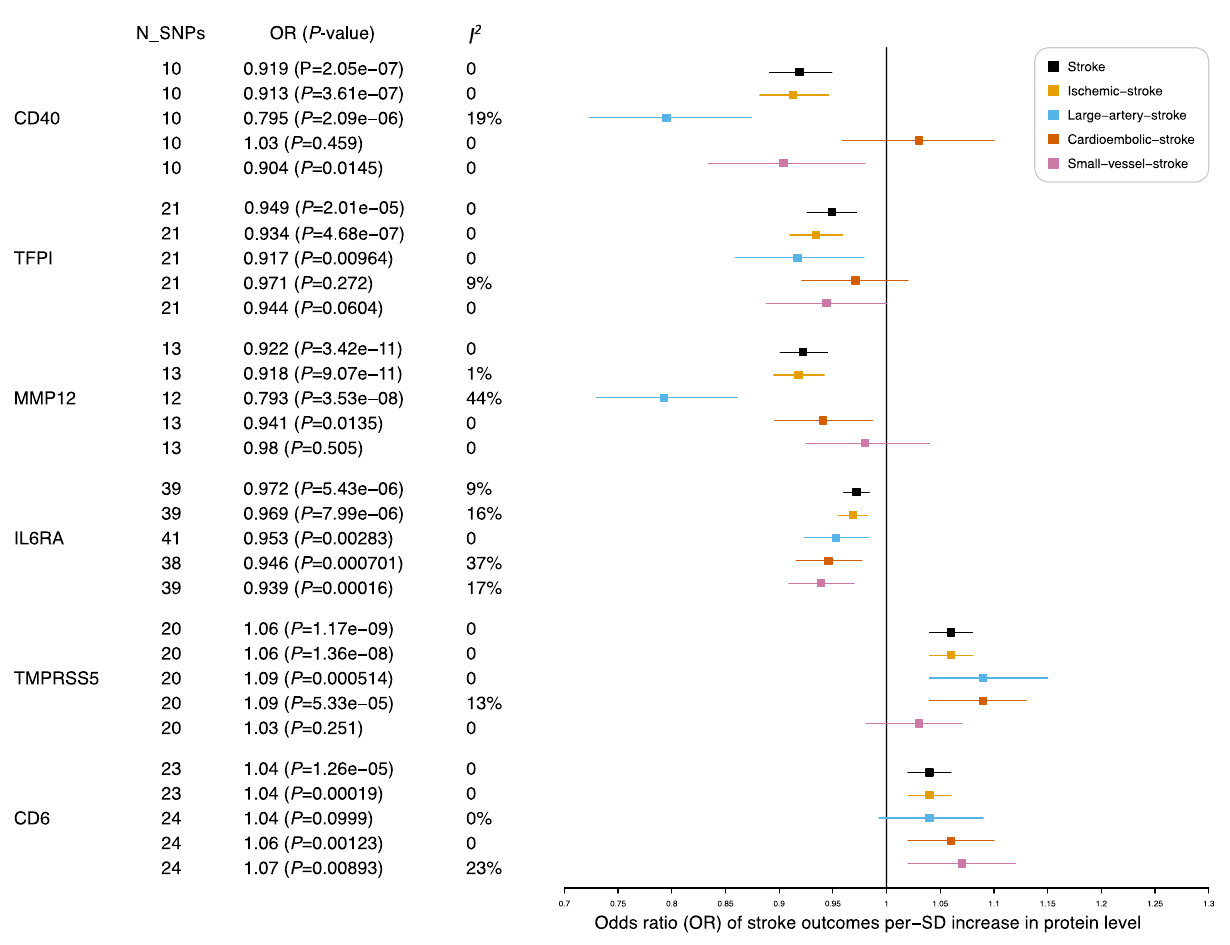
method. Statistical heterogeneity wasassessed using the I 2 statistic. ORodds